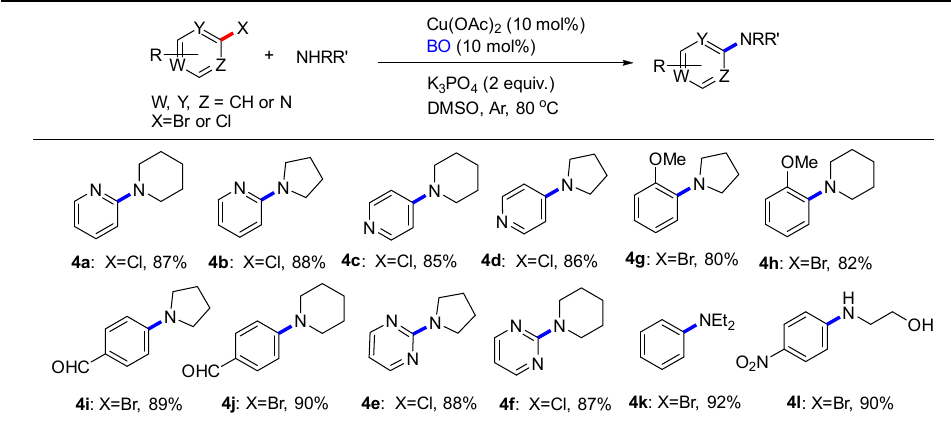
Table 3. C-N Coupling reactions of substituted aryl compounds with amines a,b .